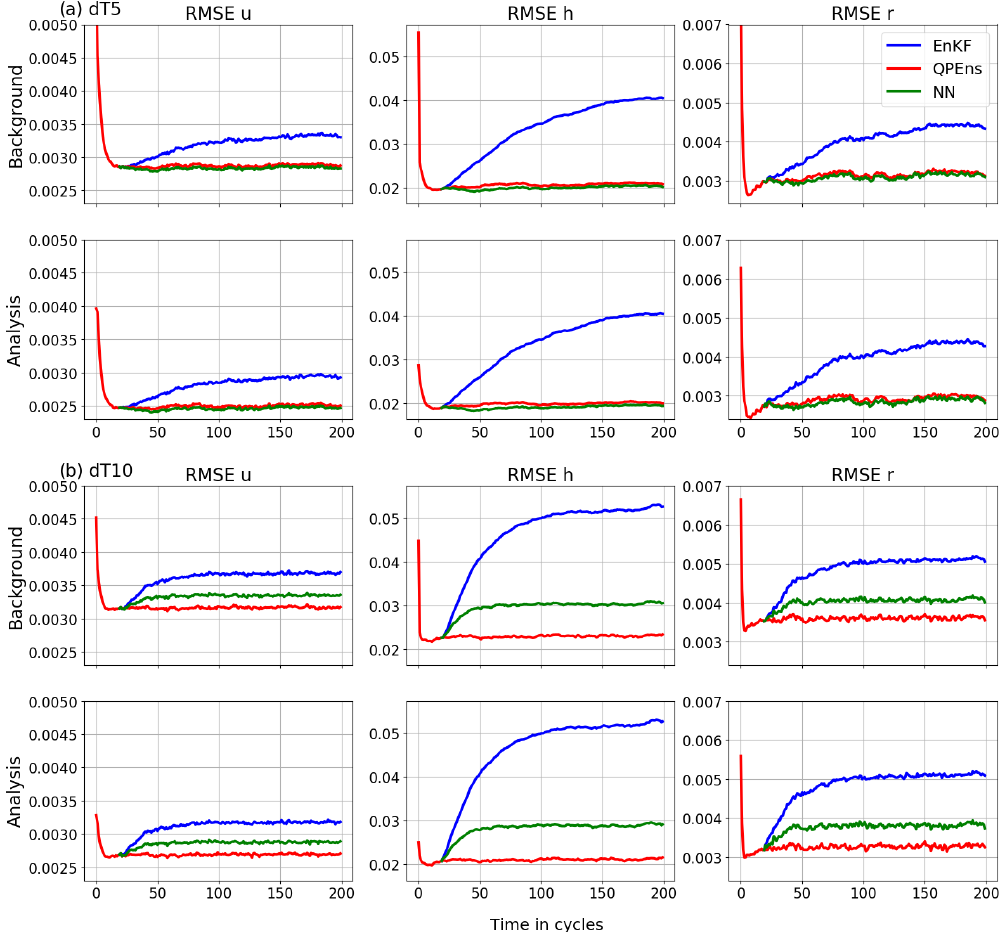
Figure 3. Root mean squared error (RMSE) of the ensemble averaged over 500 experiments of the variables (columns) for the background (top rows) and analysis (bottom rows) as functions of the assimilation cycles for the EnKF (blue), the QPEns (red) and the CNN (green). The panels in (a) correspond to dT5 and the panels in (b) to